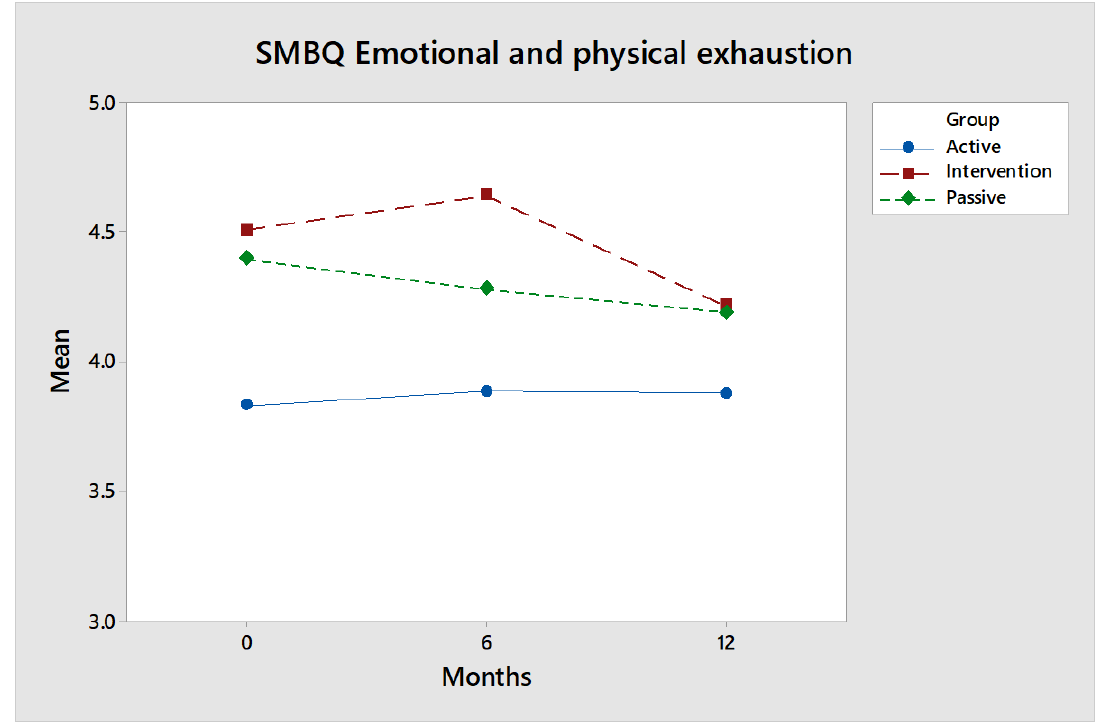
Figure 6. No significant di ff erences over time between the intervention group and the control groups with respect to the dimension SMBQ emotional and physical exhaustion. However, the values of the intervention group are improved between 6 and 12